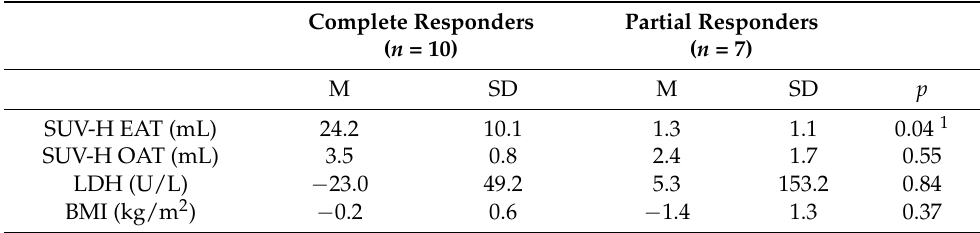
Figure 6. Delta SUV-H EAT and SUV-H OAT volumes, serum LDH levels, and BMI in complete and partial responders. ( a ) Greater delta SUV-H EAT volume was observed in complete responders than in partial responders ( p = 0.04). ( b – d ) There were no statistically significant differences in the delta SUV-H OAT volume, serum LDH levels, or BMI between complete and partial responders, with p values of 0.55, 0.84, and 0.37, respectively. * Differences are significant at the 0.05 level (two- tailed). SUV-H EAT, high standardized uptake value epicardial adipose tissue; SUV-H OAT, high standardized uptake value orbital adipose tissue; LDH, lactate dehydrogenase; BMI, body mass in- dex; CR, complete response; PR, partial response.